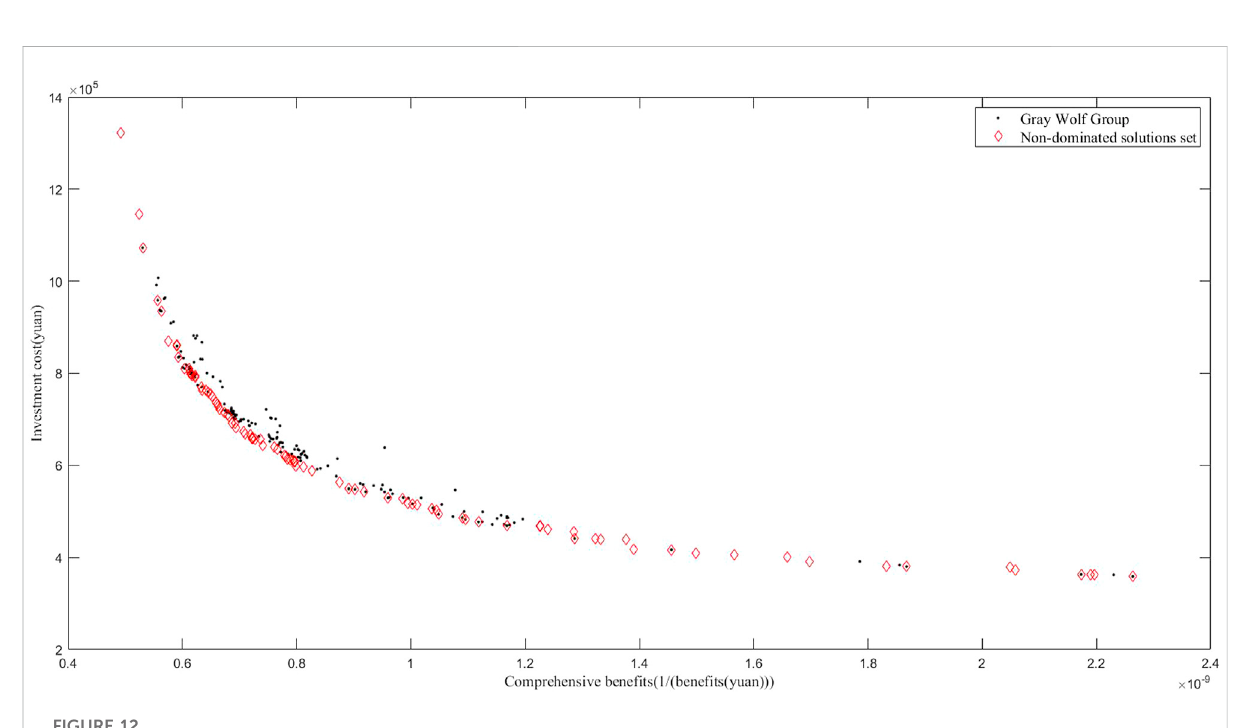
FIGURE 12 Pareto Frontier solution set under Case